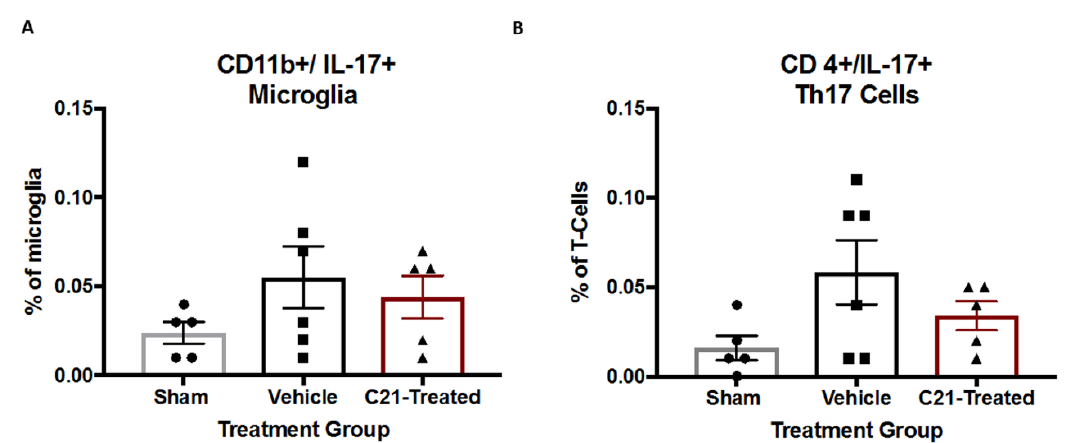
Figure 5. C21 did not alter IL-17 levels in the ischemic hemisphere. ( A ) C21 administration did not alter IL-17-producing microglia (Iba1+/Il-17+). ( B ) C21 did not alter CD4+/Th17 cells. One-way ANOVA (n =